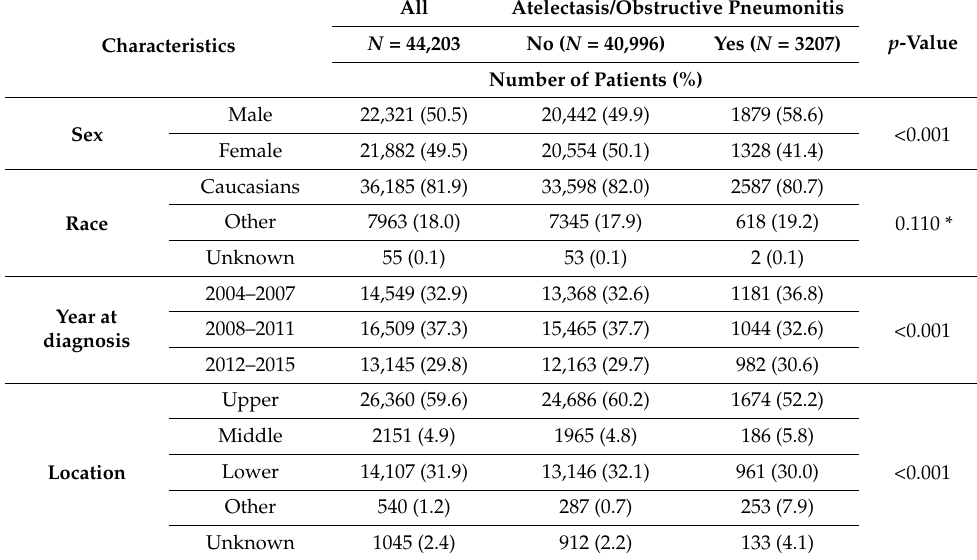
Table 1. Patient characteristics in this